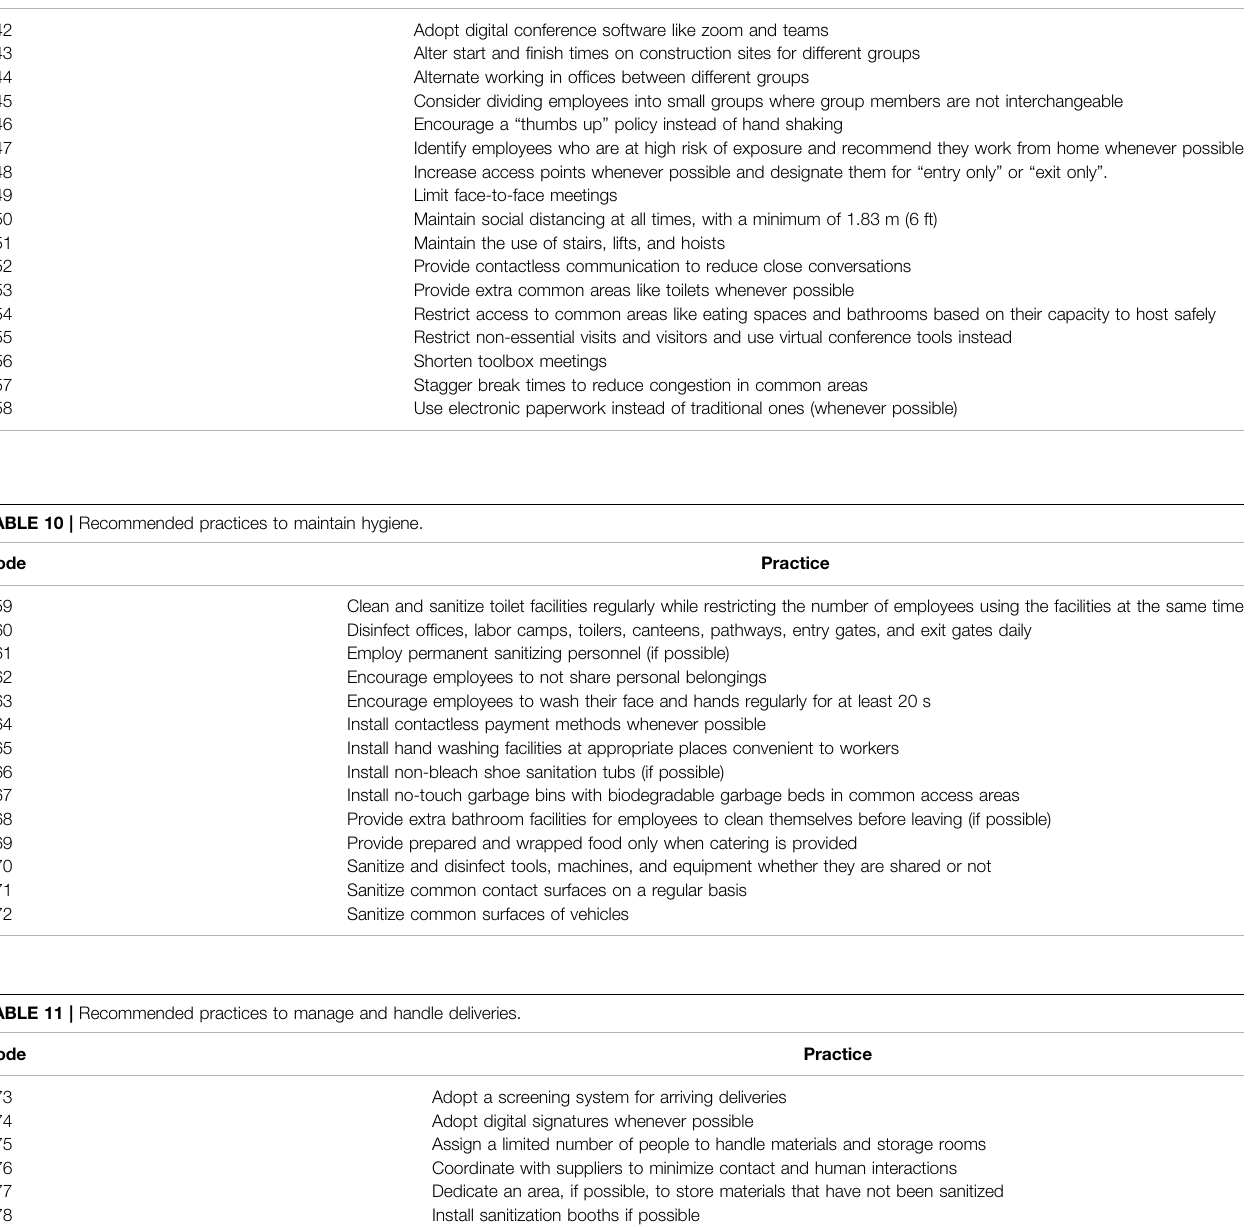
TABLE 9 | Recommended practices to minimize human interactions. Code